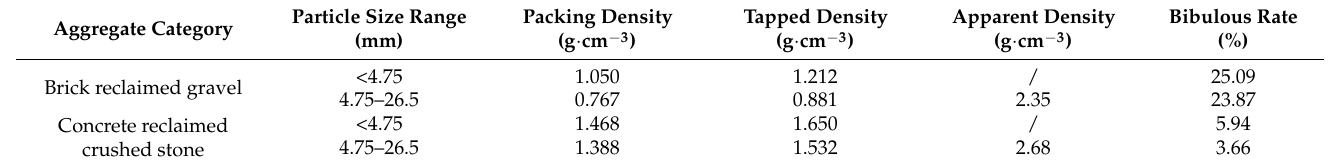
Table 3. Physical indexes of reclaimed gravel from brick and